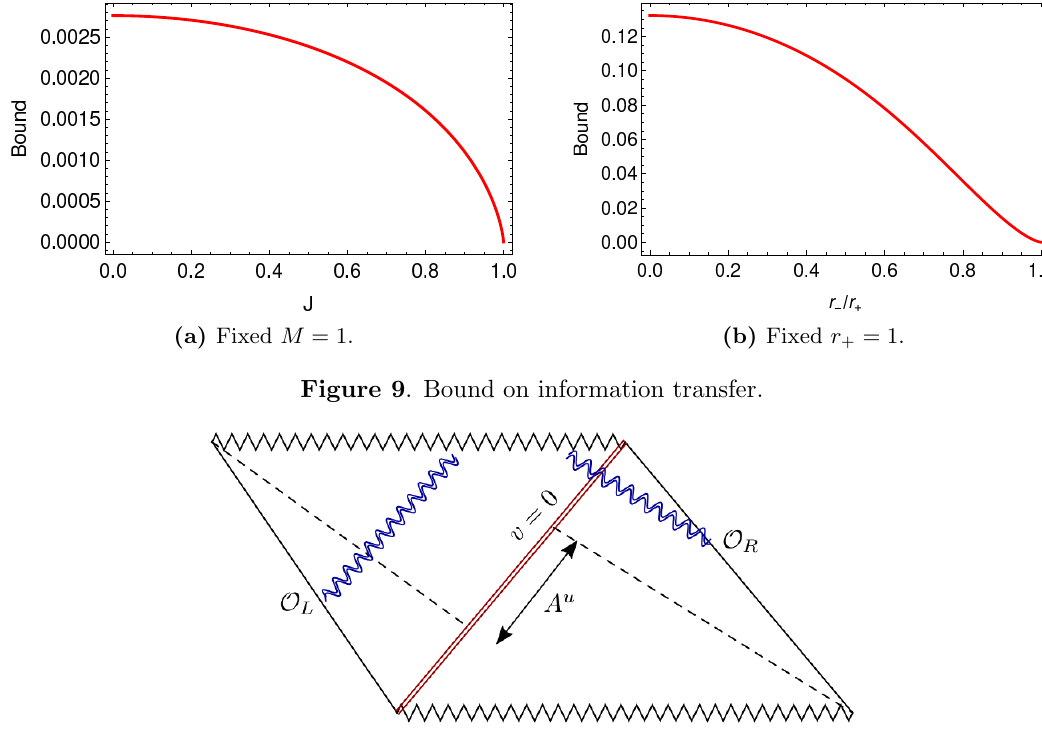
Figure 10 . The backreaction of (cid:30) produces a shock wave geometry. The wavefunction associated to O R su(cid:11)ers a time delay when it crosses the horizon at v =